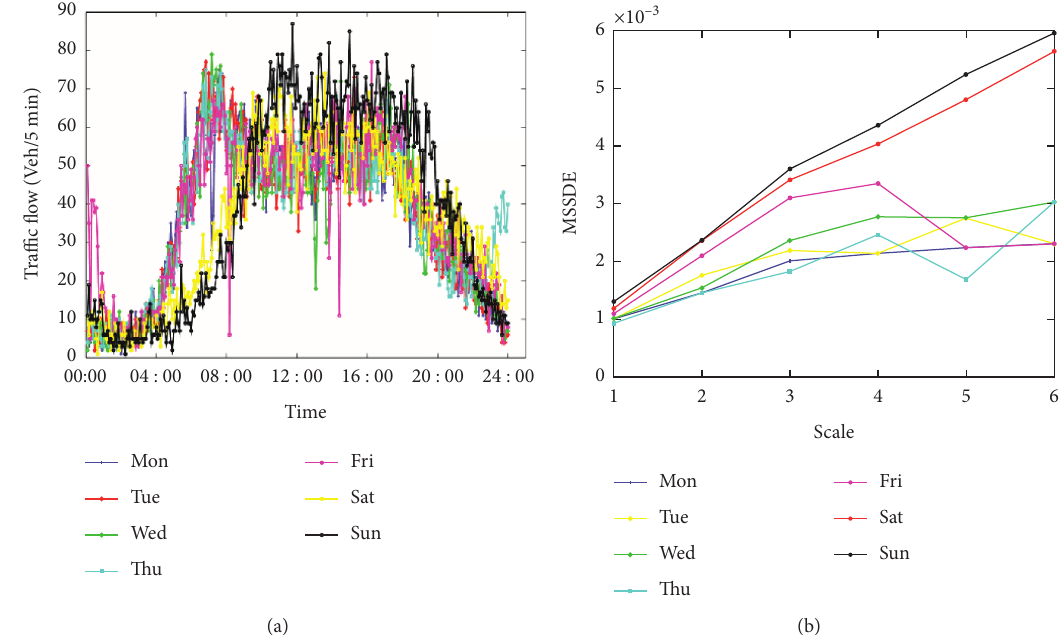
Figure 8: The result of traffic data collected by detector 5566. (a) The traffic data collected of week model from Monday to Sunday. (b) The result of analysis on the traffic day using the proposed